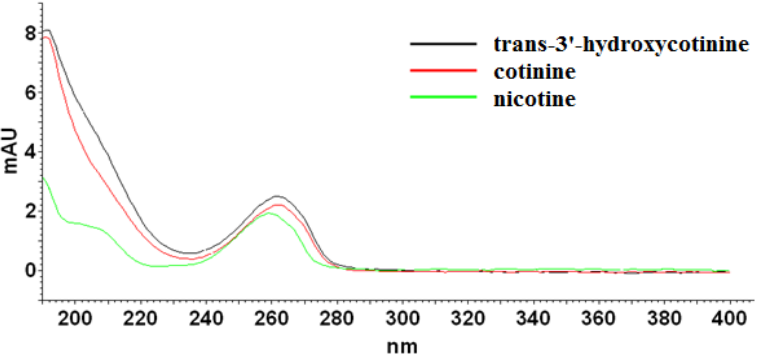
Figure 2. UV-absorption spectra of nicotine, cotinine, and trans -3 ′ -hydroxycotinine standards measured from 220 to 400 nm.